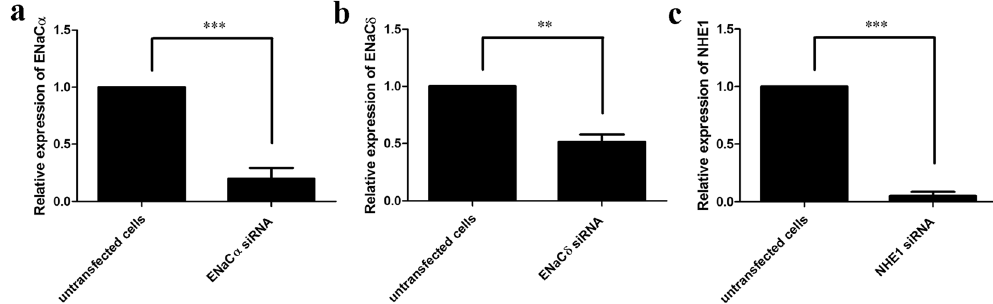
Figure 5. ENaC α , ENaC δ , and NHE1 mRNA expression in both transfected and untransfected cells. mRNA expressions of ENaC α (a) , ENaC δ (b) , and NHE1 (c) were significantly decreased in siRNA-transfected cells. Each experiment was performed three times. * p < 0.05, ** p < 0.01, *** p < 0.001, transfected vs. untransfected